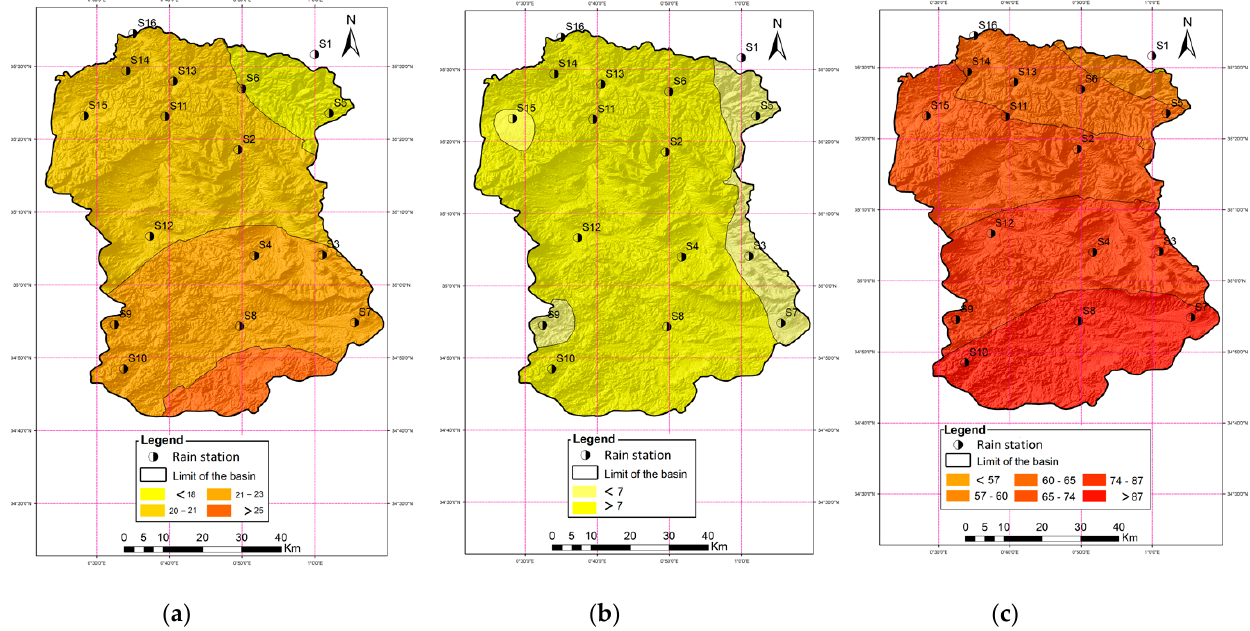
Figure 6. Return periods of meteorological droughts in Wadi Mina with ( a ) moderate; ( b ) severe; and ( c ) extreme severities.